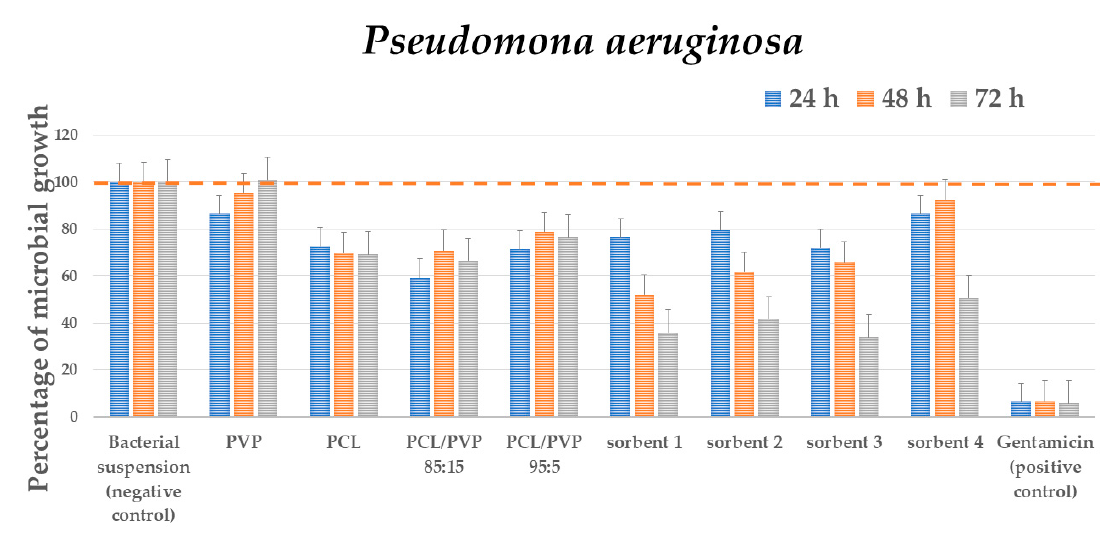
Figure 7. Percentage of microbial growth of exposed Pseudomona aeruginosa to PCL / PVP fibers and sorbents, at 24, 48 and 72 h.